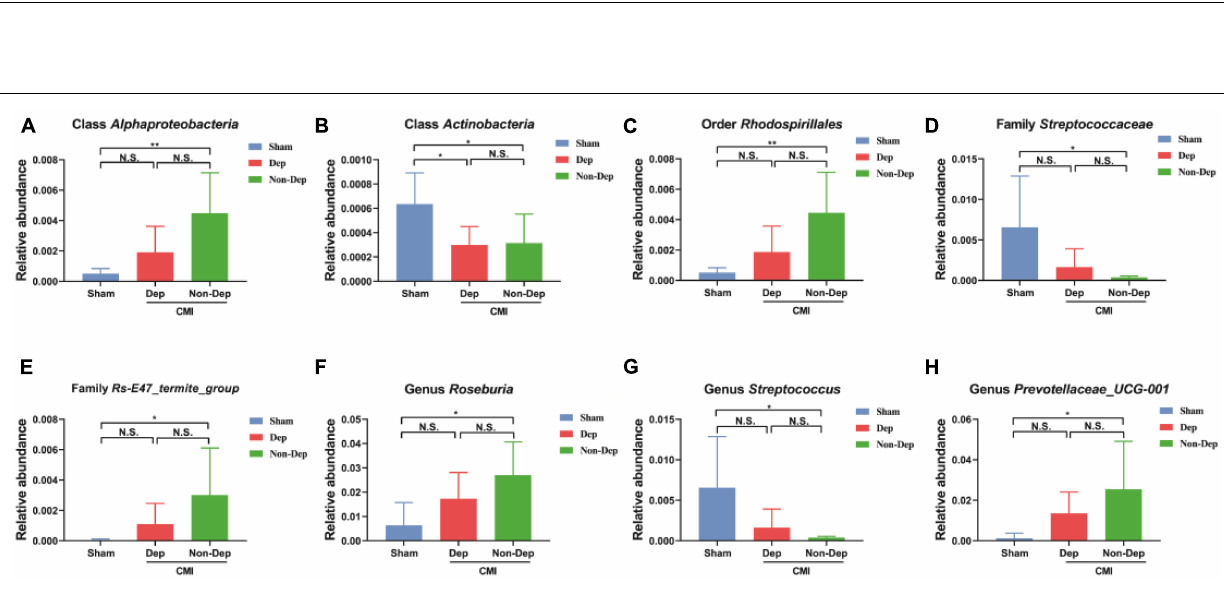
Frontiers in Microbiology |